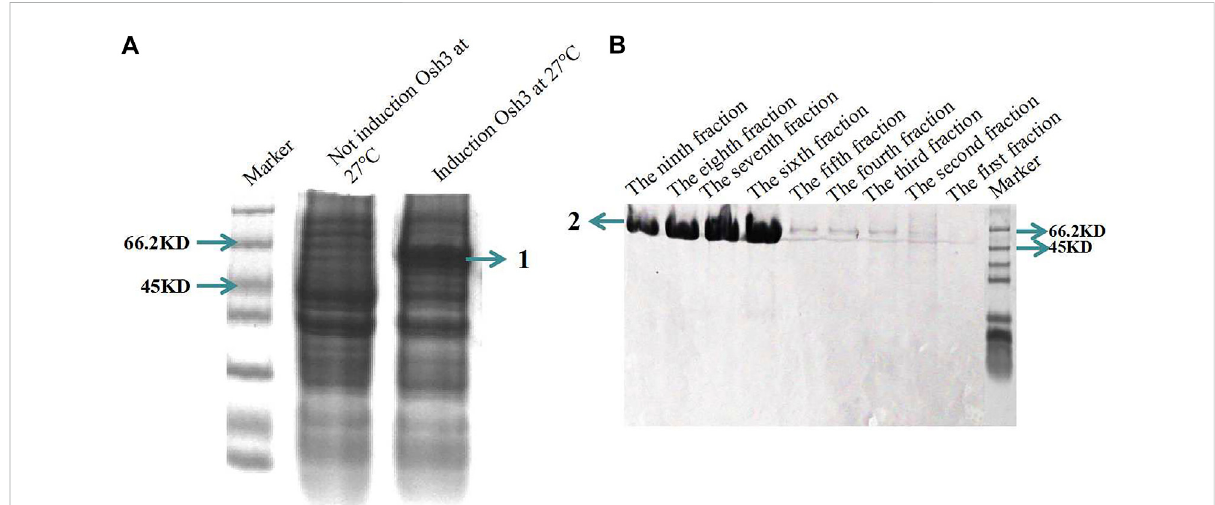
FIGURE 6 Osh3 in pET28 vector was expressed in E. coli Transseta DE3 and puri fi ed using His Ni-agarose resin. (A) SDS-PAGE analysis of the induced Osh3. 1) Induced Osh3. (B) Osh3 was puri fi ed using His Ni-agarose resin; the amount of the puri fi ed protein was highest in fractions 6 – 9. Each fraction (tube) is 1 ml eluent. 2) Puri fi ed